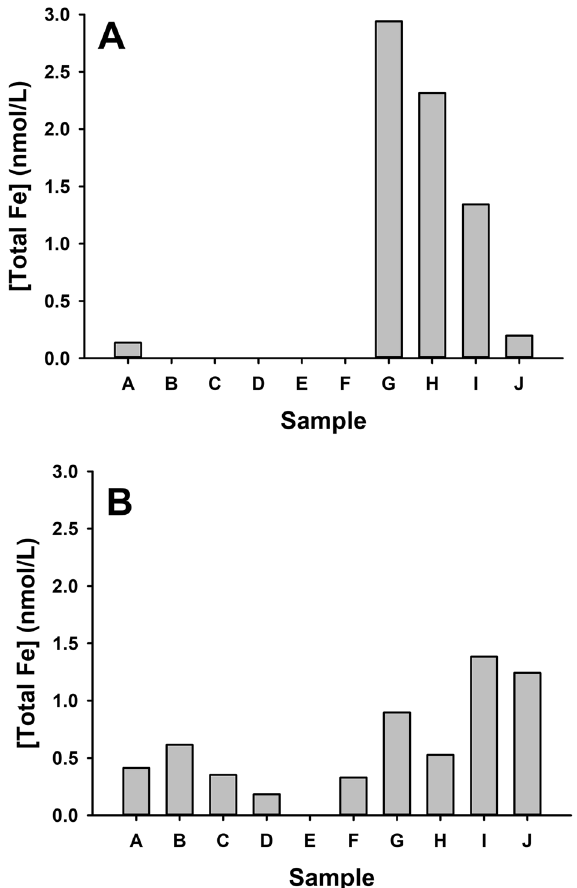
Figure 1. Bioavailable iron (total Fe) for the 10 coal samples measured after 24 h in Gamble’s solution ( A ) or artificial lysosomal fluid (ALF; B ) measured by ferritin